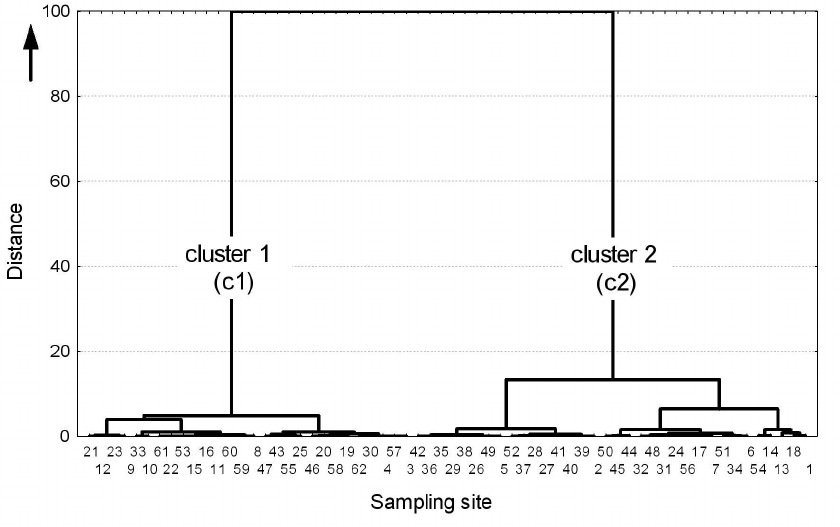
Fig. 5 Hierarchical dendrogram for classification of sampling sites according to factor